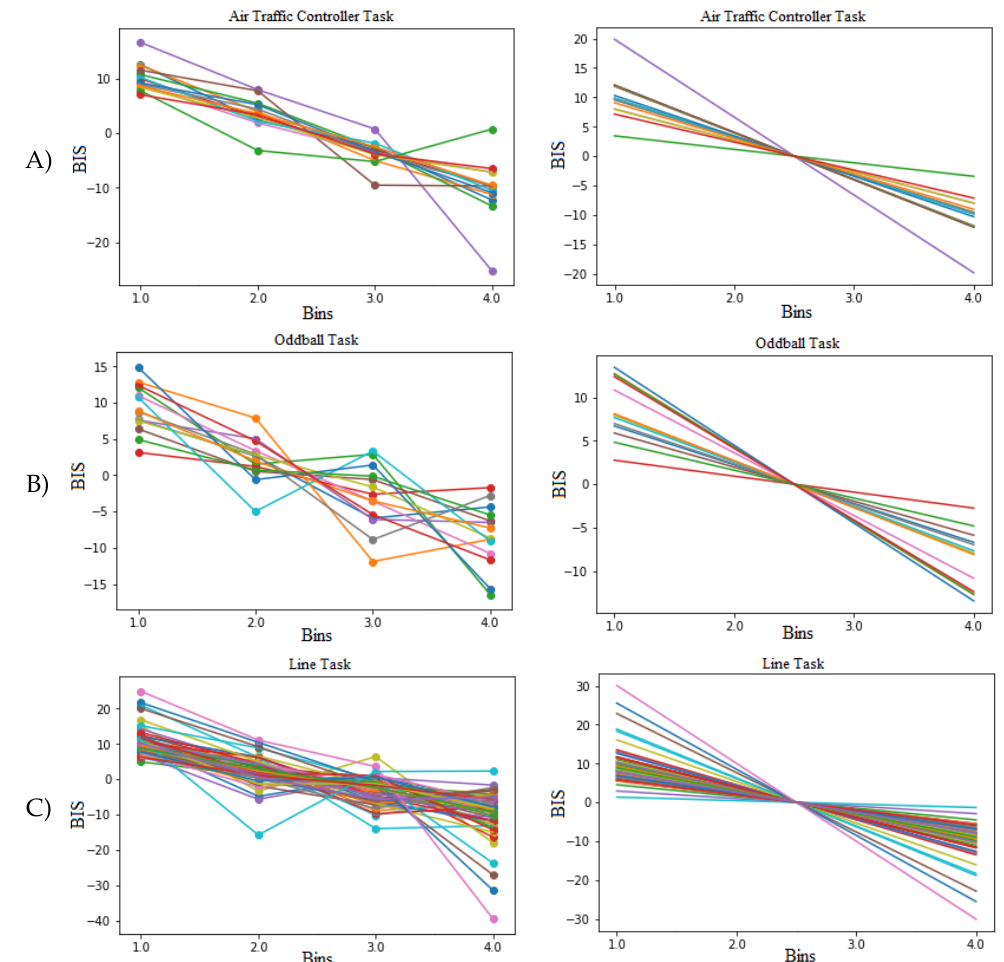
Figure 4. BIS measures and the corresponding best-fit lines for: ( A ) Air Traffic Controller task (top), ( B ) Oddball task (middle), and ( C ) Line task (bottom). The lines represent a participant’s BIS measures over the duration of the task, with lines on the right being best-fit lines. BIS measures vary from bin to bin for each participant, with some participants decreasing steadily throughout the entire task, some decreasing initially and then recovering, or some alternating between decreasing and increasing BIS. Note that every participant’s best-fit line has a negative slope, indicating that every participant’s first bin is their most attentive bin with their largest BIS